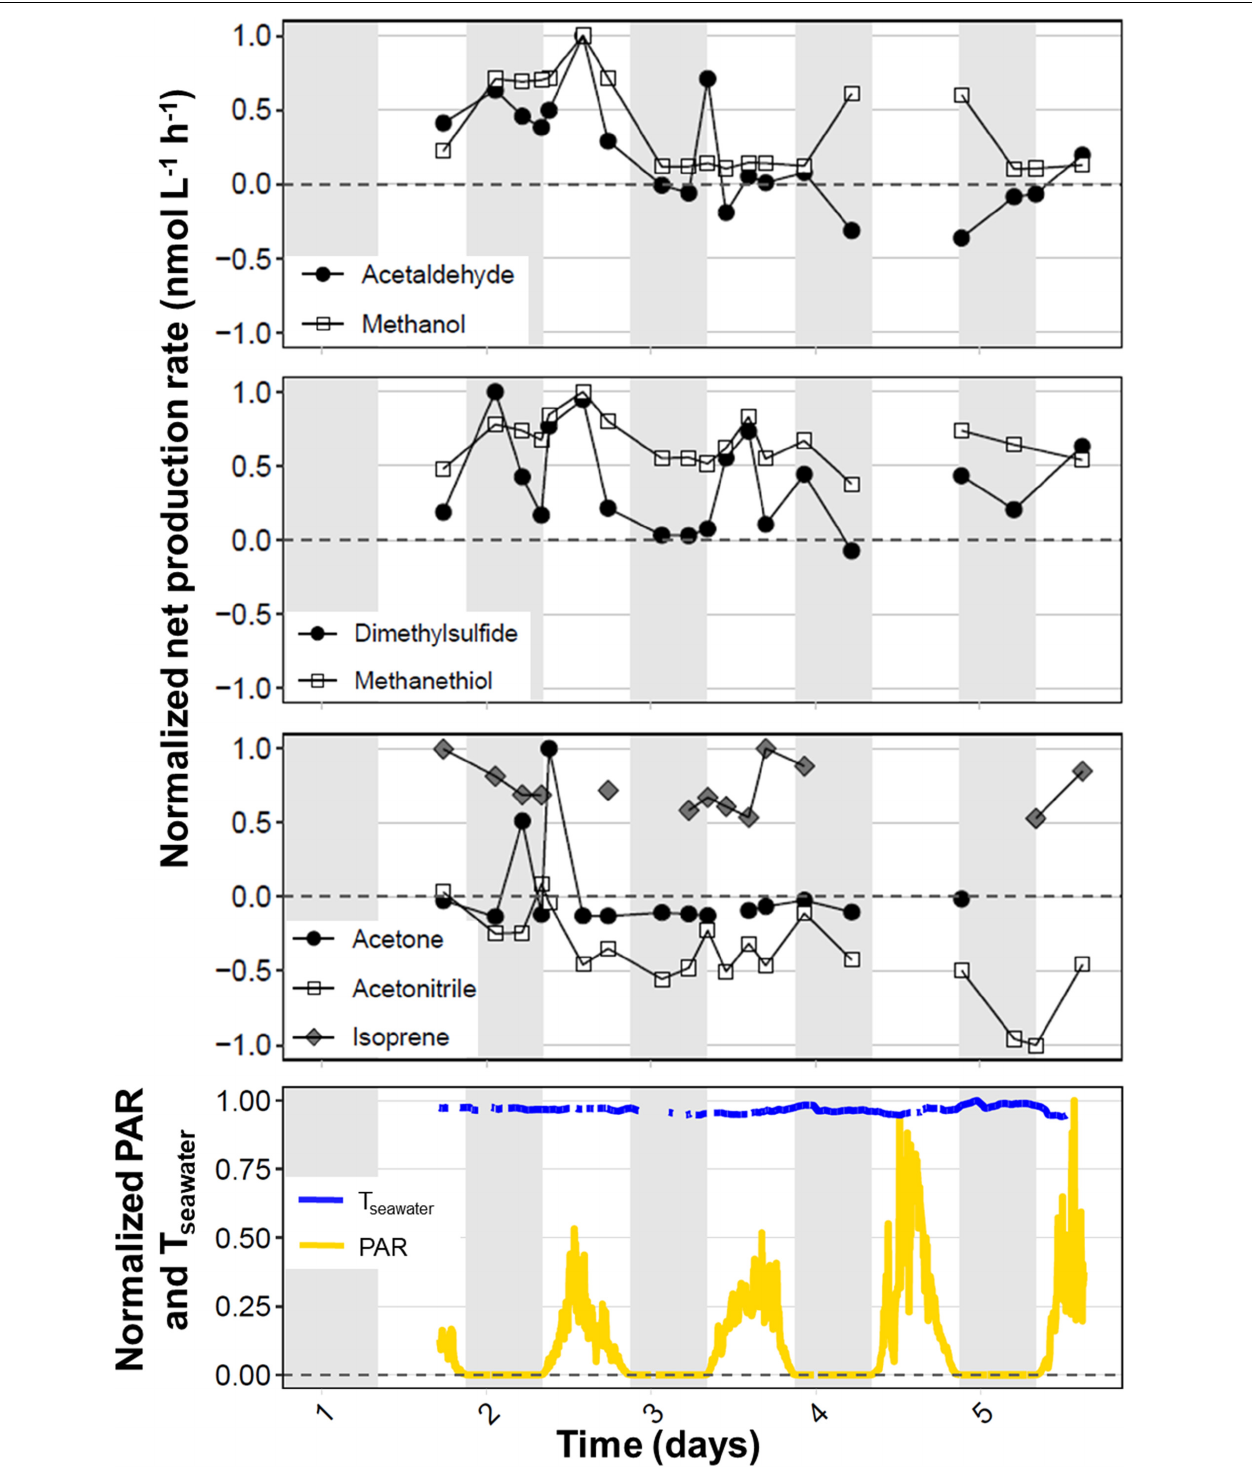
FIGURE 5 | Timeseries showing diel variability in net VOC production rates during a 97-h occupation at the northernmost station (53.376 ◦ N, –39.542 ◦ W) during the September field campaign. Net production rates were normalized to the highest absolute net production rate observed for each target VOC during the long-term station. The horizontal dotted line represents a net production rate of zero and the gray shading indicates periods of darkness ( ∼ 21:00 to 08:00 UTC). The bottom panel shows the photosynthetically active radiation (PAR, µ mol photons m − 2 s − 1 ) and seawater temperature (T seawater , ◦ C), also normalized to their highest values (1657 µ mol photons m − 2 s − 1 and 12.1 ◦ C,